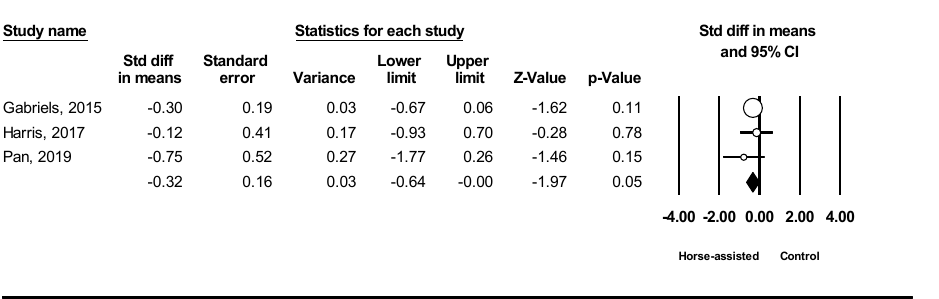
Figure 8. Forest plot showing the effects of horse-assisted therapy vs. control on lethargy [44–46]. The pooled meta-analysis results from the three studies in Figure 9 showed that horse-assisted therapy produced a significantly positive effect on hypersensitivity in children with ASD (SMD = − 0.70, 95% CI [ − 1.29, − 0.10], p = 0.02).